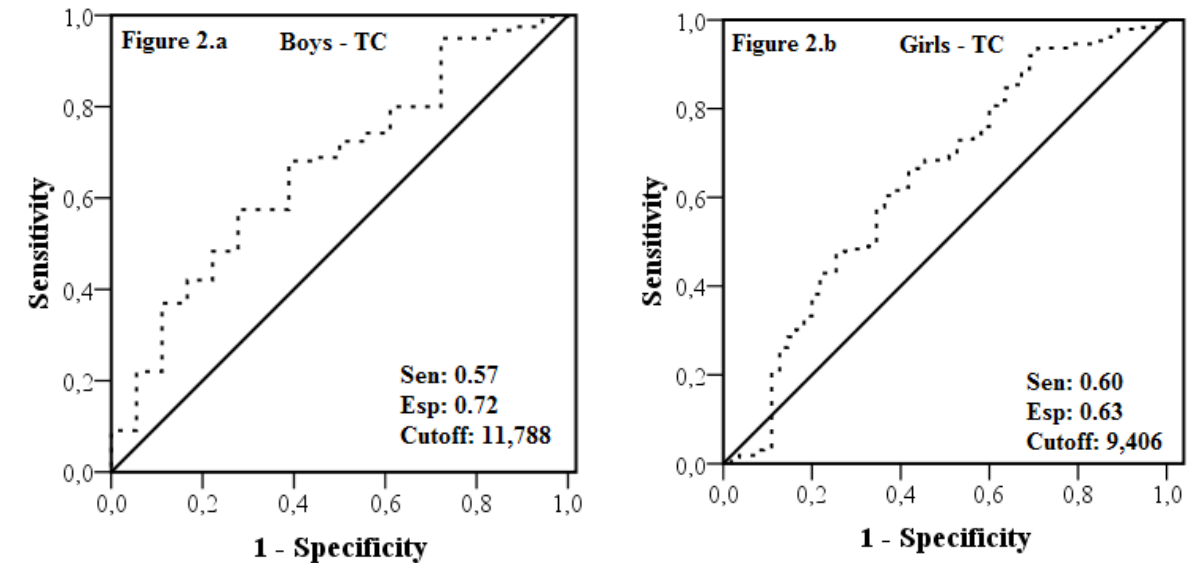
Figure 2. Area under ROC curve between the number of steps/day and increased total cholesterol in boys (figure 2.a) and girls (figure